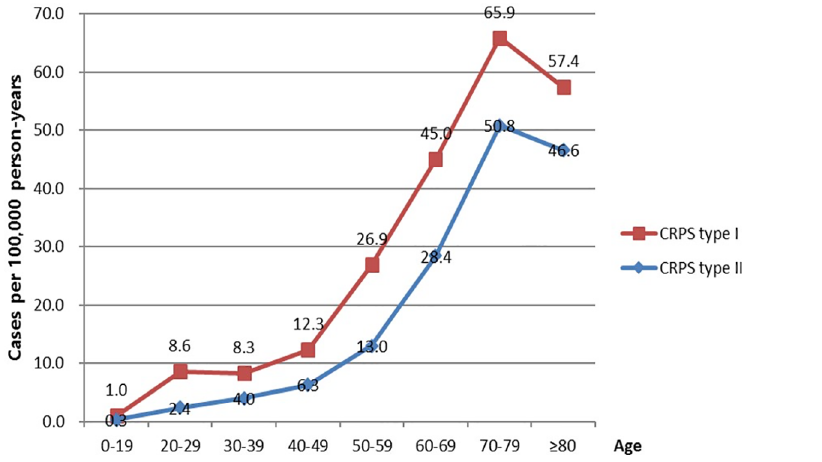
Fig 3. Distribution of CRPS by patient age group in